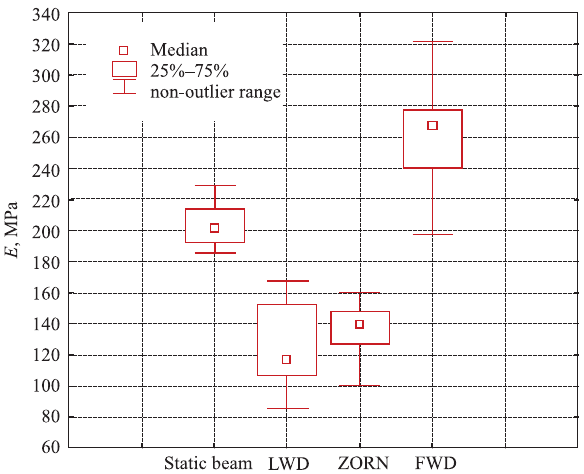
Fig. 5. Evaluation of measuring results on a base course layer by all the